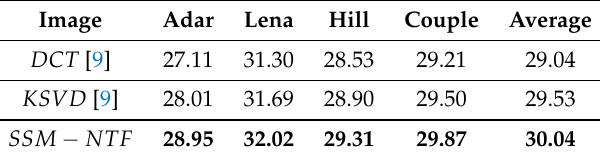
Figure 9. Visual quality comparison of scratch image inpainting results. From left to right: Original image, scratch image, result of DCT ( PSNR = 30.81), KSVD ( PSNR = 31.69), and our SSM-NTF method ( PSNR = 32.02), respectively. Table 4. PSNR (dB) for image inpainting